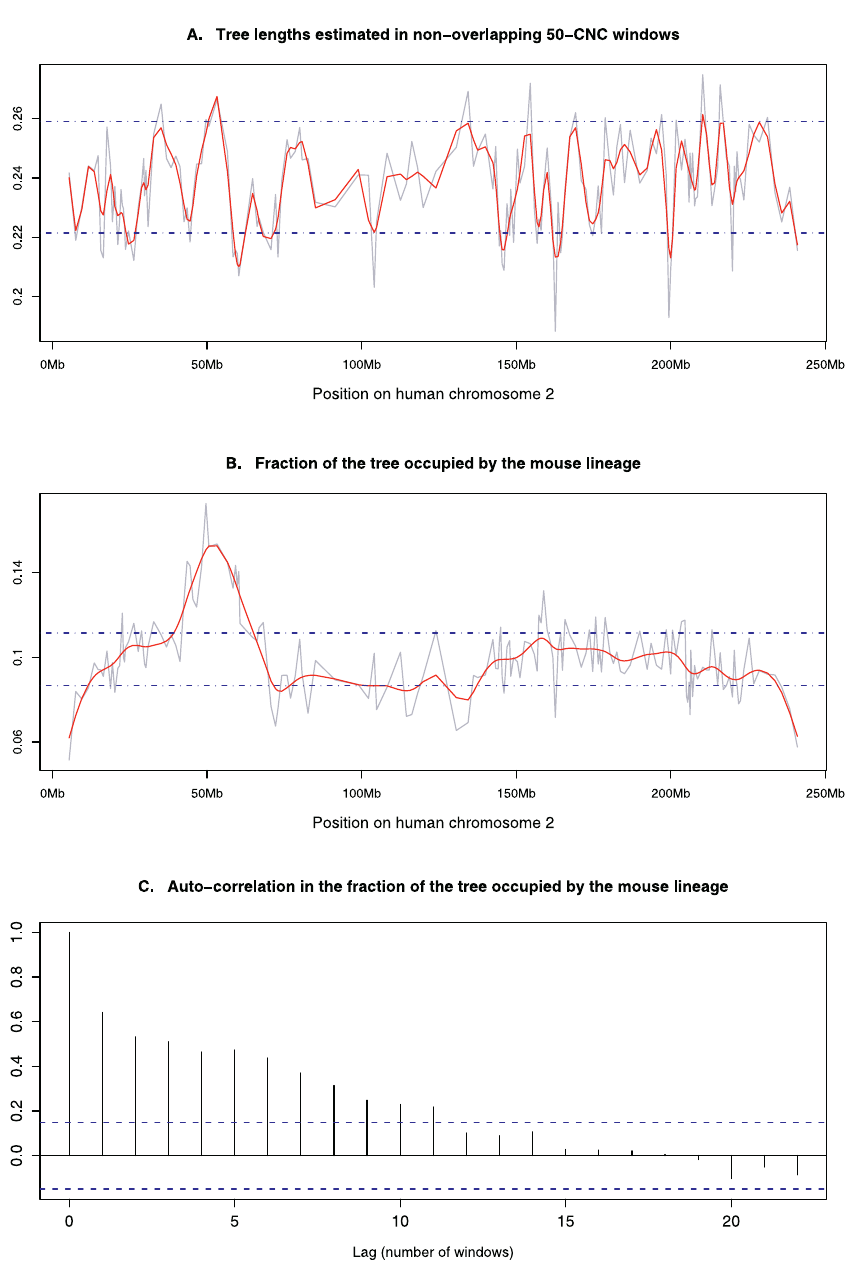
Figure 2. Local Variation in the Tree Shape in Mammalian CNCs Located on Human Chromosome 2 Values for the upper two plots are calculated in nonoverlapping windows of 50 consecutive CNCs. (A) Local variation in total tree lengths (average number of substitutions per site). Both the raw data (gray) and the smoothed data (red) are shown. The dashed blue horizontal lines indicate the 2.5% and 97.5% quantiles of the (unsmoothed) distribution expected if there were no spatial heterogeneity (estimated by randomly shuffling the location of Chromosome 2 CNCs). (B) Fraction of the tree occupied by the mouse lineage. (C) Long range dependence in the fraction of the tree occupied by the mouse lineage. The plot shows the correlation between windows separated by a gap of i other windows; values outside the dotted lines are significant at the 5% level. The Durbin-Watson test for autocorrelation is significant at p , 10 (cid:2) 15